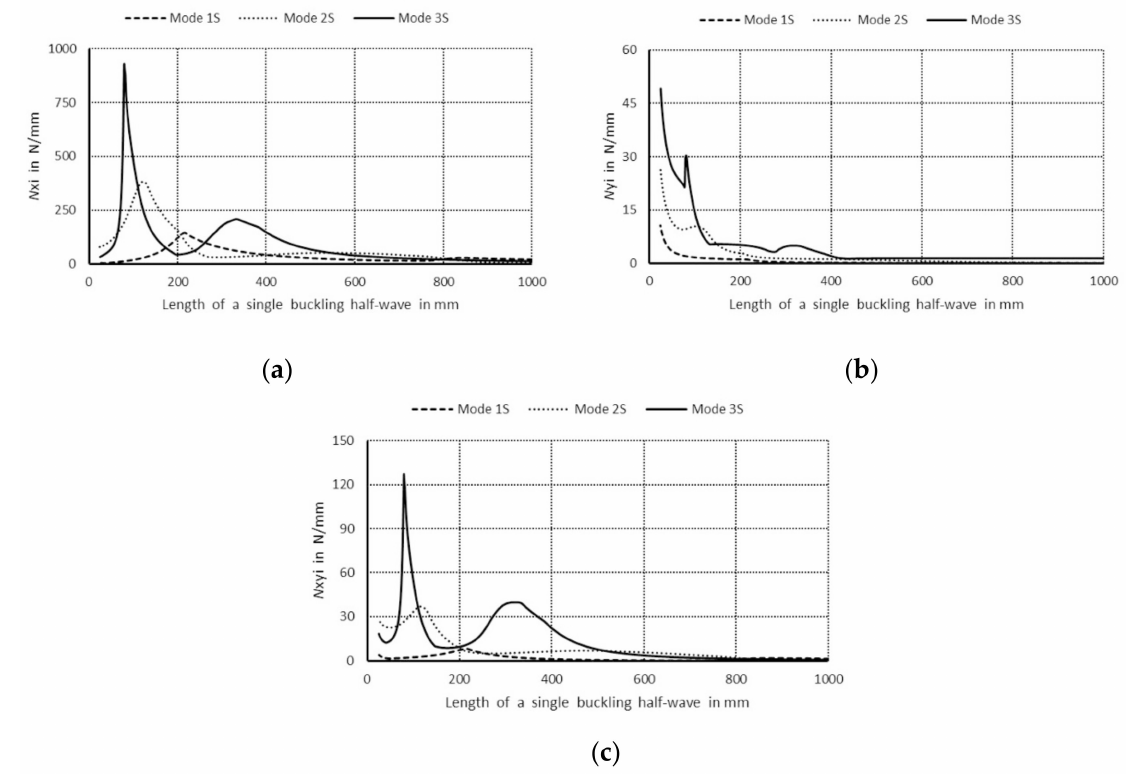
Figure 12. Maximal absolute values of membrane forces in N/mm for symmetrical buckling modes: ( a ) longitudinal forces N xi , ( b ) transverse forces N yi and ( c ) shear forces N xyi as a function of the length of a single buckling half-wave in mm.